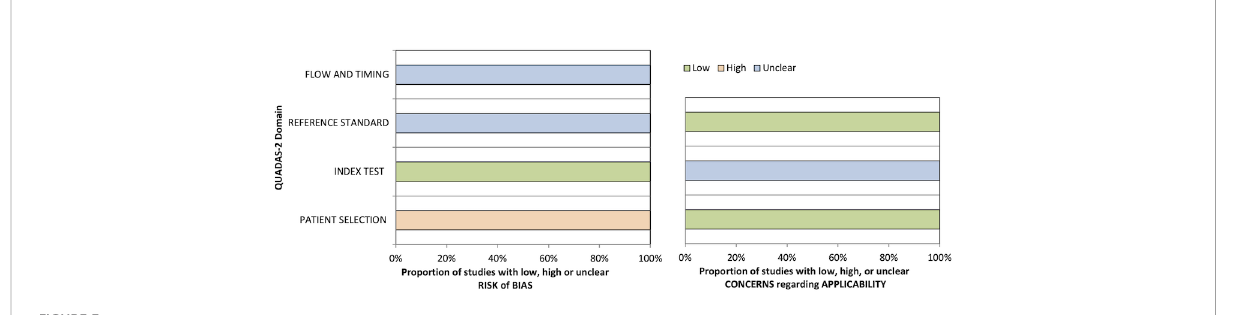
FIGURE 3 Graphical summary of QUADAS-2 results for segmentation